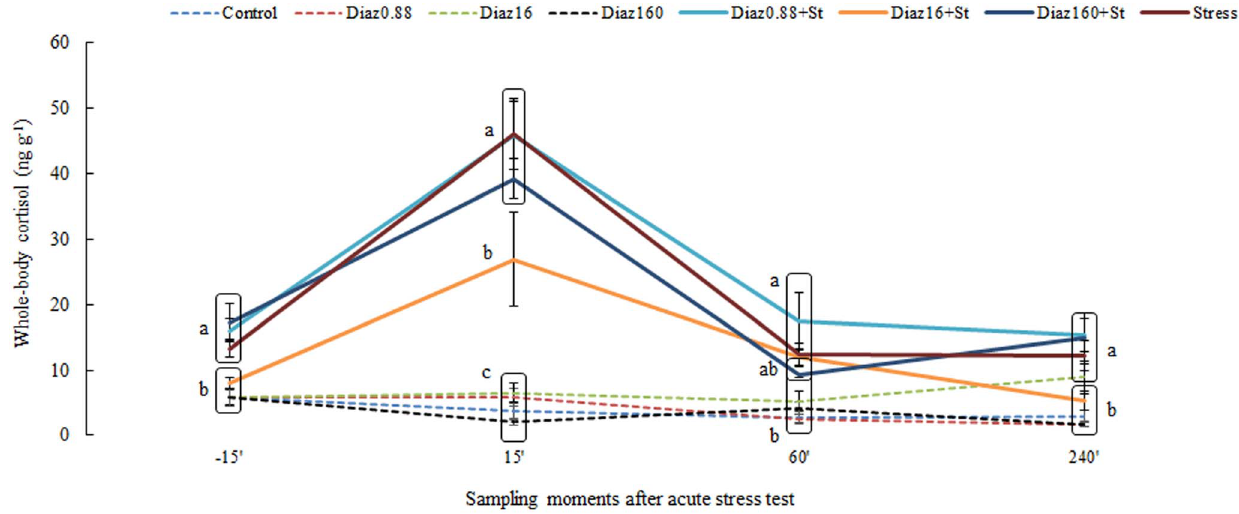
Figure 2. Whole-body cortisol concentrations in zebrafish to diazepam followed by an acute stress test and respective controls. The values are expressed as the mean 6 standard error of mean. Different small letters indicate significant group differences in each sampling time.